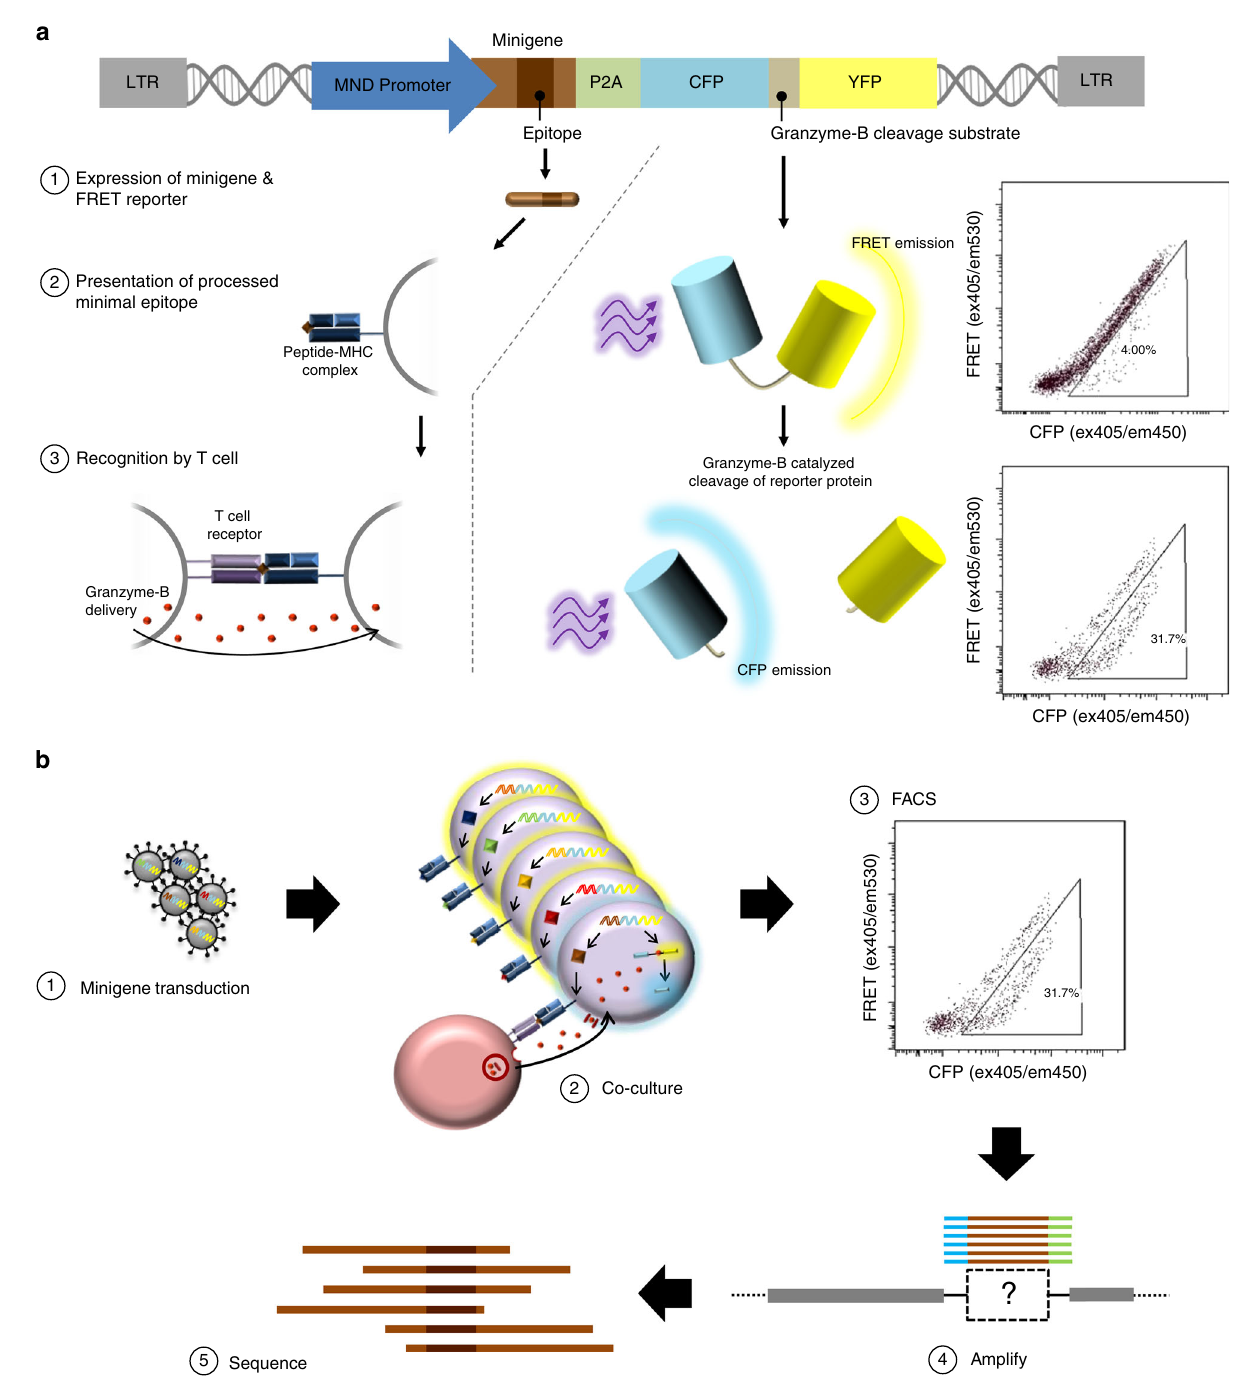
Fig. 1 Summary of epitope-screening method. a In the absence of GZMB, the reporter protein emits a resting FRET signature when excited with violet light. Upon entry of GZMB to the cell, the reporter is cleaved. The loss of resting FRET signal combined with the rescue of free CFP signal results in a FRET-shift that can be monitored in FACS to isolate cells undergoing T-cell targeting. b Target cells are provided with libraries of lentivirally delivered short-peptide- coding minigene sequences and exposed to T cells of interest. Any targets recognized by T cells are then subject to GZMB loading and cleavage of their internally expressed FRET reporter. Cells carrying putatively antigenic minigenes are isolated by FACS, minigenes encoded within these cells are recovered by PCR, and the resultant amplicons are characterized by deep target cell line separately. Flow-cytometric analyses of co- capable of ef fi ciently detecting target cells harboring the correct cultures indicated that SIINFEKL + cells underwent signi fi cant antigen (Fig. 2a, b). ( p < 0.0001 by unpaired, one-tailed Student ’ s t test) and sub- stantial (Cohen ’ s d > 40) cleavage of their encoded reporter GZMB delivery to targeted cells is highly speci fi c . Once protein relative to the scrambled negative control. These data provide evidence that the FRET-shift assay described herein is the GZMB-sensitive FRET-shift assay was shown to be